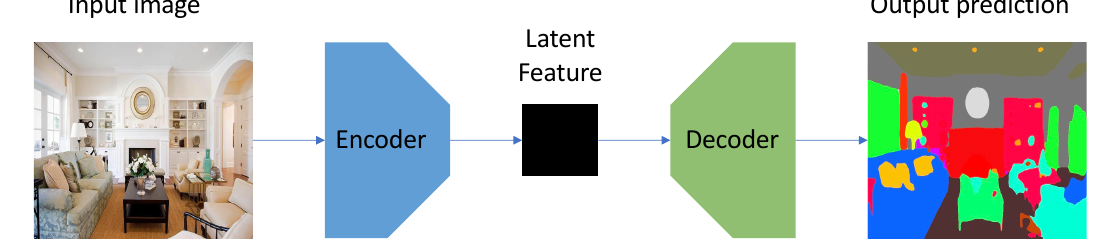
Figure 1. The architecture of a simple encoder–decoder model. Images taken by monocular cameras only contain three color channels of RGB. When humans observe these 2D RGB images, we can easily reconstruct the location distribution and geometric relations of objects in the real scenes according to previous